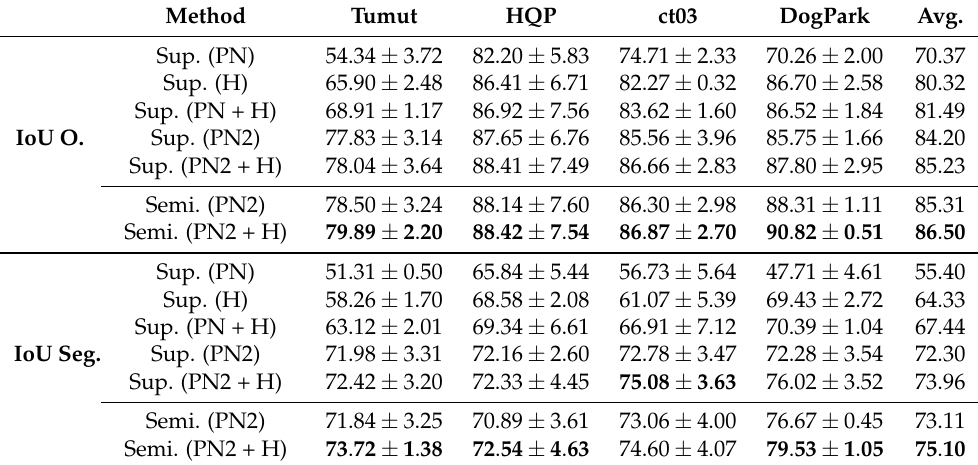
Table 3. The overall IoU (IoU O.) and average IoU over height segments (IoU Seg.) of the point cloud semantic segmentation methods under the semi-supervised learning setting, where each training set has only 5 labelled examples. We compare the results of our semi-supervised methods (denoted as Semi. ) using two different backbone models with the supervised baselines (denoted as Sup. ). We report the average results and standard deviations over the three different training and validation splits for each dataset and we highlight (in bold) the best result across different methods on each